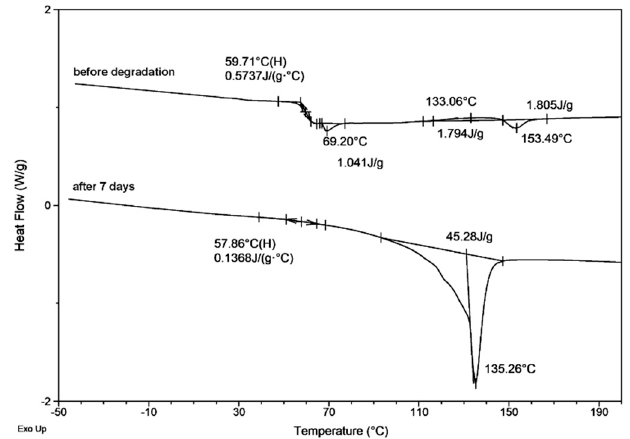
Figure 6. Selected DSC curves for the PLA dumbbell-shaped specimen PLA-1 / 165V-7, obtained by 3D printing at 1 mm / s and 165 min in vertical direction before and after 7 days of hydrolytic degradation.